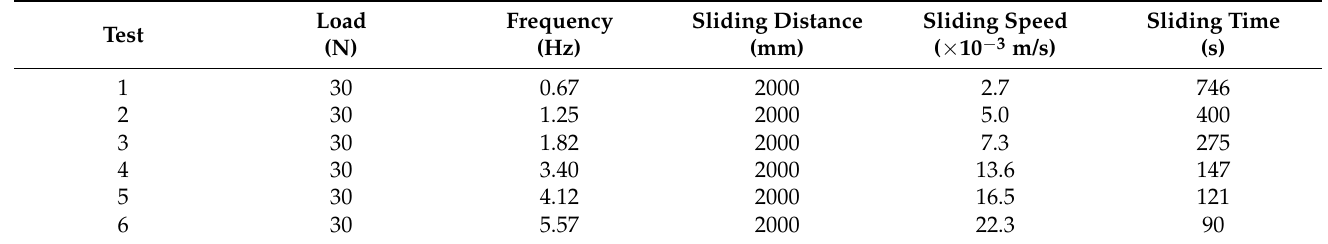
Table 5. Test conditions used in the reciprocating sliding test (lubricated with PAO 8—Polyalphaolefin 8, ν 40 = 46 mm 2 /s).